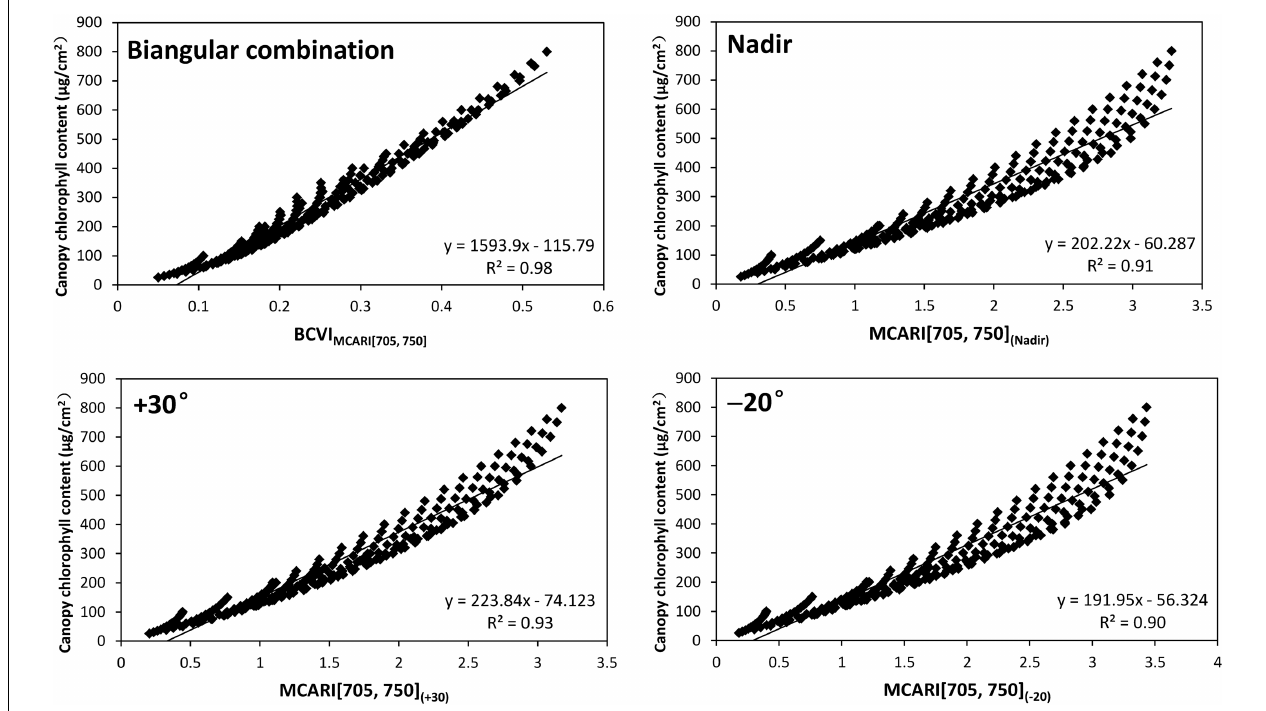
FIGURE 6 | Scatterplots of relationships between canopy chlorophyll content and the MCARI[705,750] ( Nadir ) , MCARI[705,750] ( + 30 ) , MCARI[705,750] ( − 20 ) , and BCVI MCARI [ 705 , 750 ] for model simulated